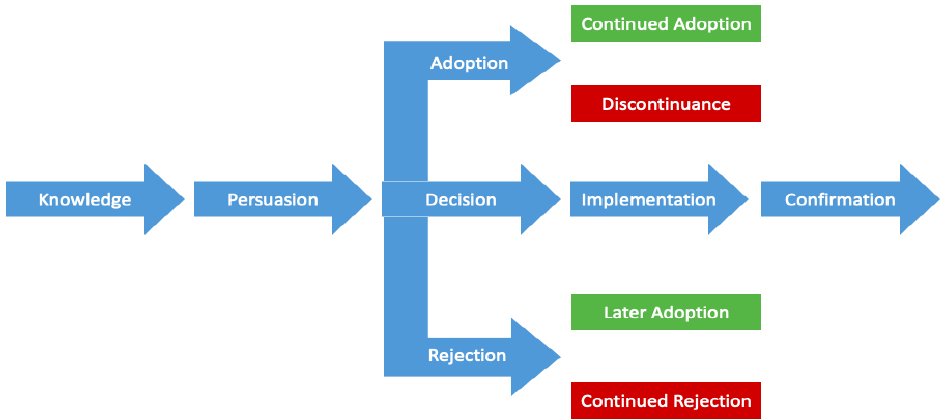
Figure 1. Rogers’ Innovation Adoption Decision Process (source: SolvInnov: http://solvinnov.com/innovation-adoption/).